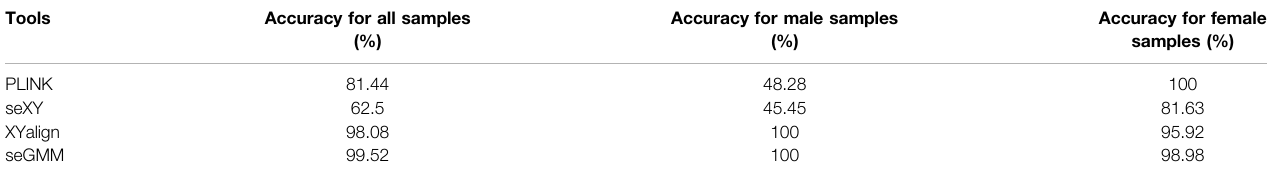
TABLE 1 | Gender prediction accuracy of different methods for samples in dataset 1. Tools Accuracy for all samples (%)